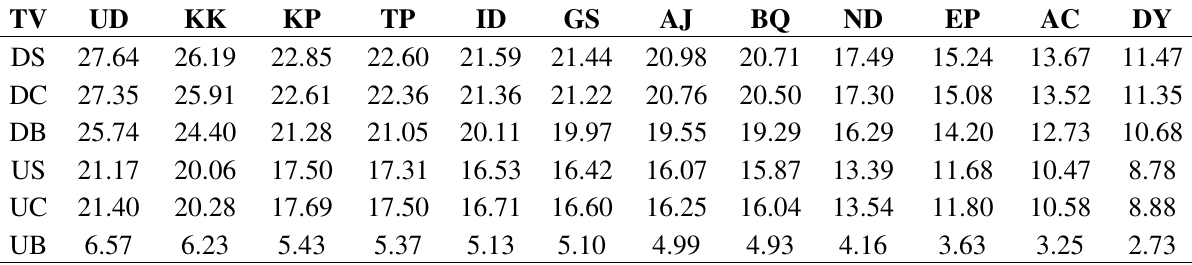
Table 6. Optimized value of (a response to fertilization on different potato varieties.